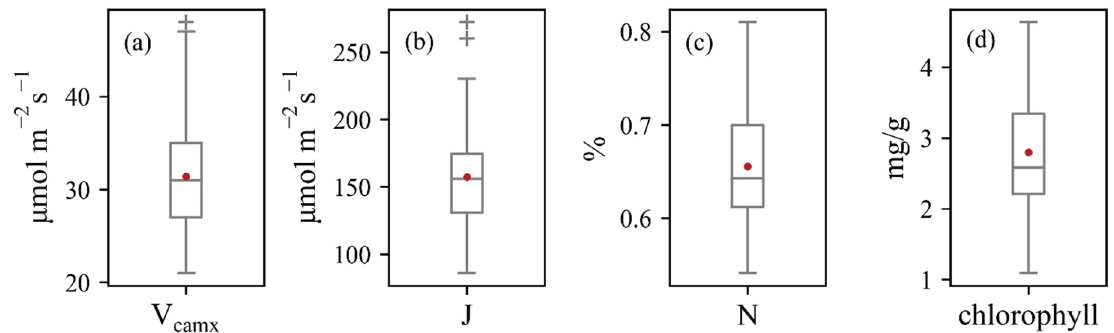
Figure 3. Box plots of the measured values of ( a ) V cmax , ( b ) J, ( c ) N, and ( d ) chlorophyll.